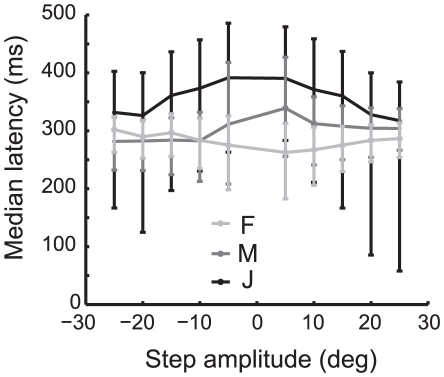
Latency to the initial response.Median latency by monkey and step amplitude. Error bars span the second and third quartiles of the data.